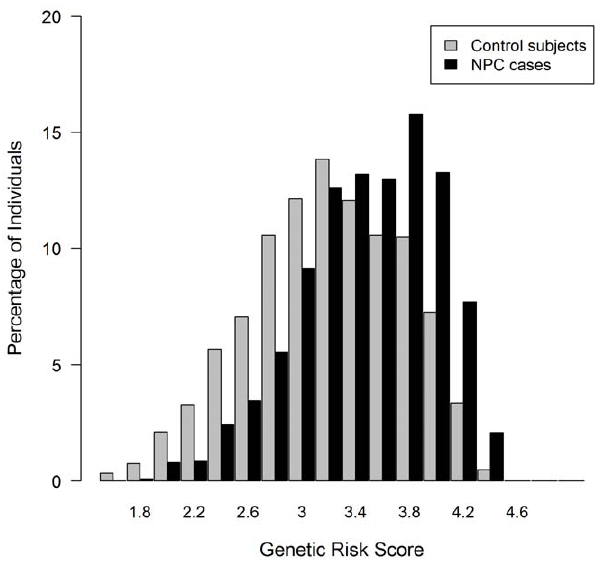
Figure 1. Distribution of genetic risk score. Distribution of the seven SNPs-based genetic risk score in 1,387 NPC cases (black bars) and 1,459 controls (grey bars). Individual risk for NPC was calculated by weighting each risk allele with its corresponding risk coefficient, which was derived from logistic regression.